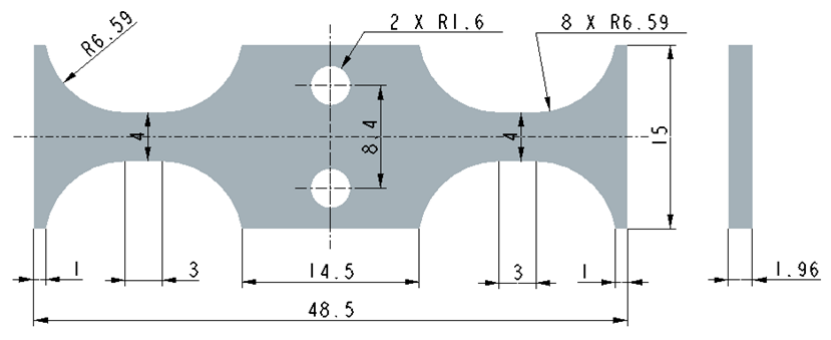
Figure 1. The geometry of the ultrasonic bending loading specimen (unit: mm).